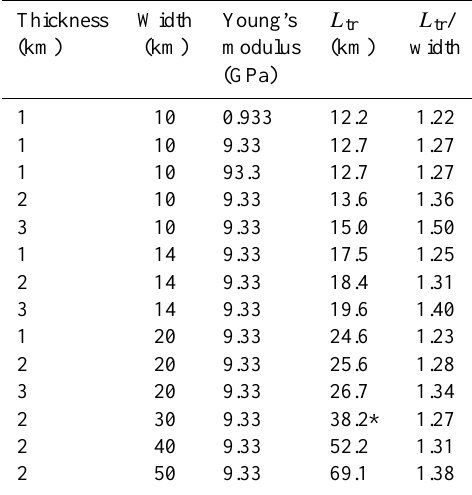
Table 5. L tr for 3-D models with uniform Young’s moduli. Like the 2-D models, L tr is effectively independent of Young’s modulus, but increases with increasing thickness and width of the ice stream. The model indicated with an asterisk is representative of Rutford Ice